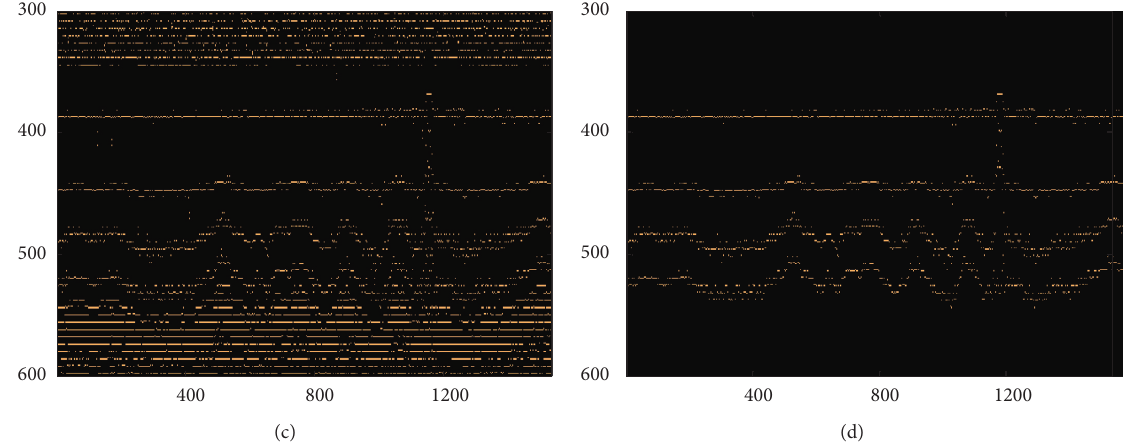
Figure 10: Image analysis: (a) focusing images, (b) image after noise reduction, (c) edge extraction, and (d) noise reduction.